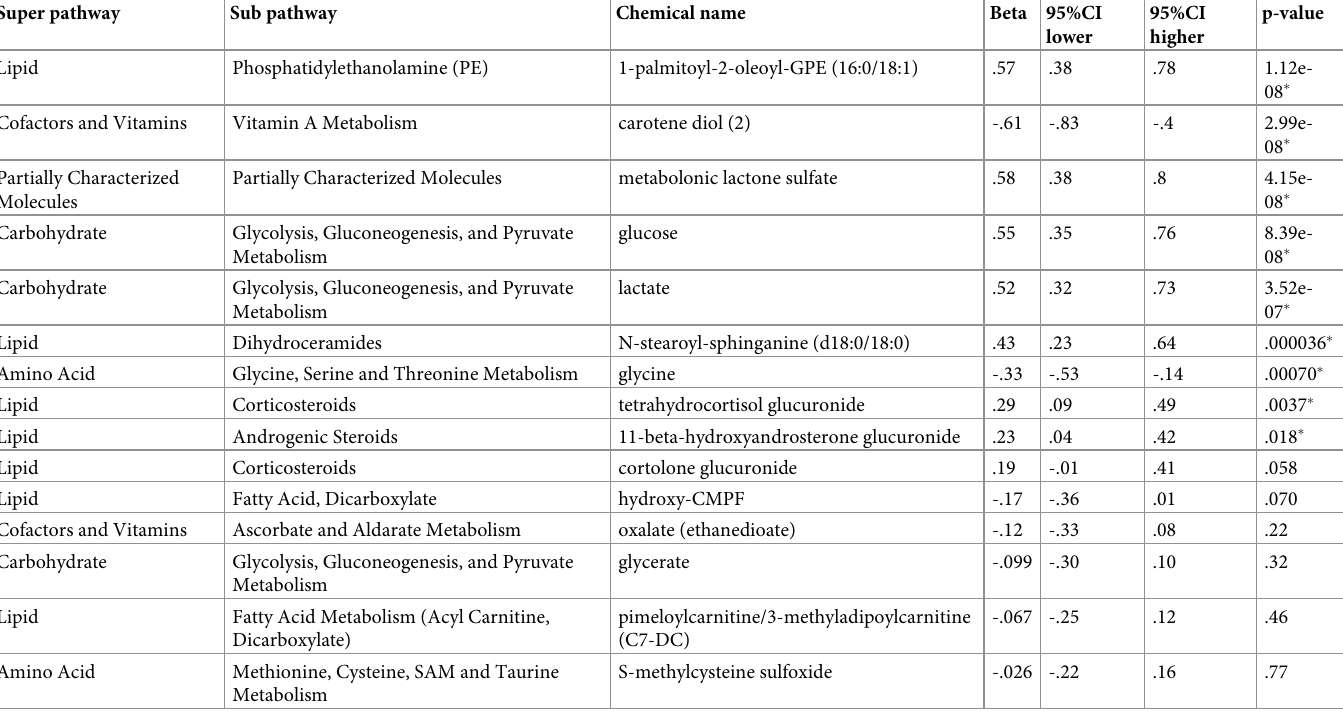
Table 2. Relationships between the 15 validated metabolites being related to all five components in the metabolic syndrome (MetS) and prevalent MetS in a meta- analysis of the PIVUS and POEM samples. The results are sorted on p-value. A star following the p-value denotes that the metabolite shows a false discovery rate (FDR) < 0.05.